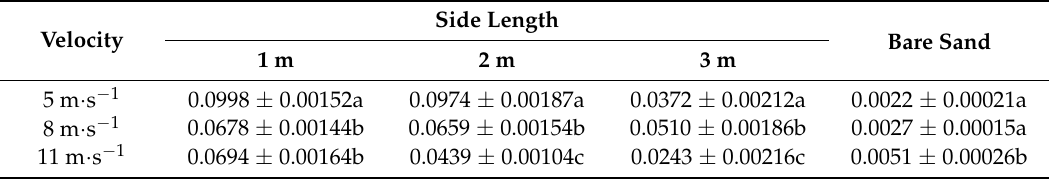
Table 1. Roughness of straw checkerboards of different side lengths